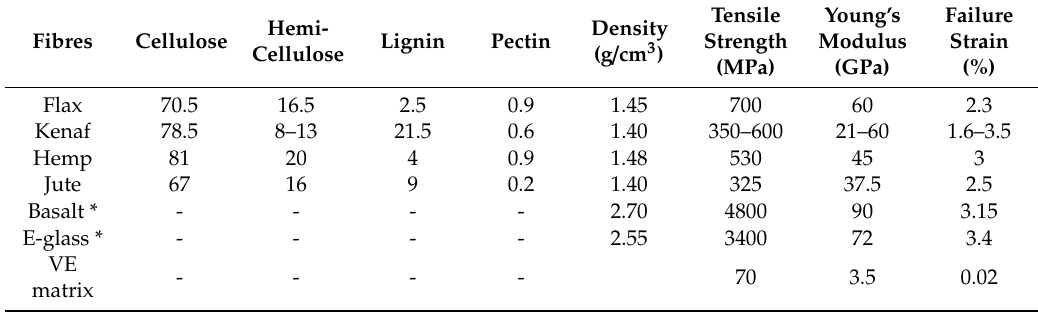
Figure 1. Reinforcements used, ( a ) flax woven fabric, and ( b ) basalt woven fabric. Table 1. Chemical composition, and physical and mechanical properties of commonly used natural bast fibres [27 –30 ].